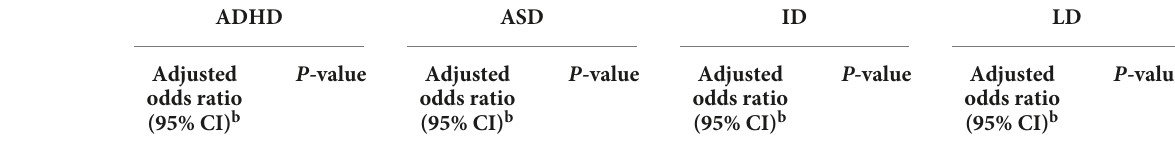
TABLE 3 Weighted logistic regression models for ADHD, ASD, ID, and LD among US children and adolescents aged 3–17 years a